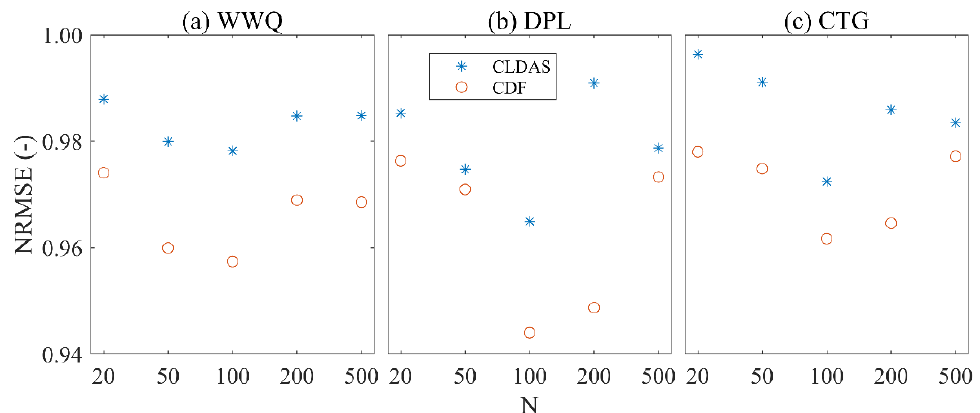
Figure 7. Variation of 𝑁𝑅𝑀𝑆𝐸 with ensemble numbers of EnKF. (a) WWQ basin; (b) DPL basin; (c) CTG basin.